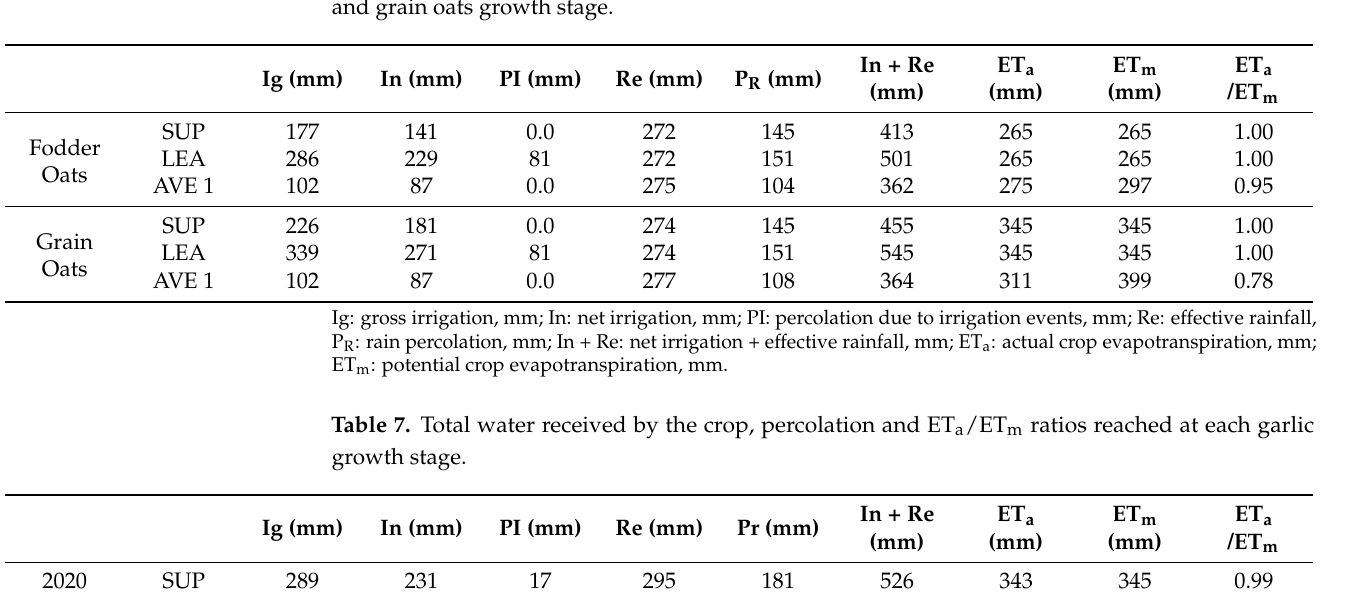
Table 6. Total water received by the crop, percolation and ET a /ET m ratios reached at each fodder and grain oats growth stage.